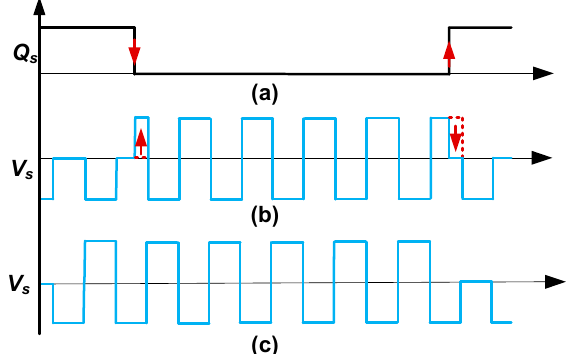
Figure 6. Difference of V s caused by the switch time ( a ) Q s switch time; ( b ) distortion of V s ; ( c ) ideal waveform of V s .